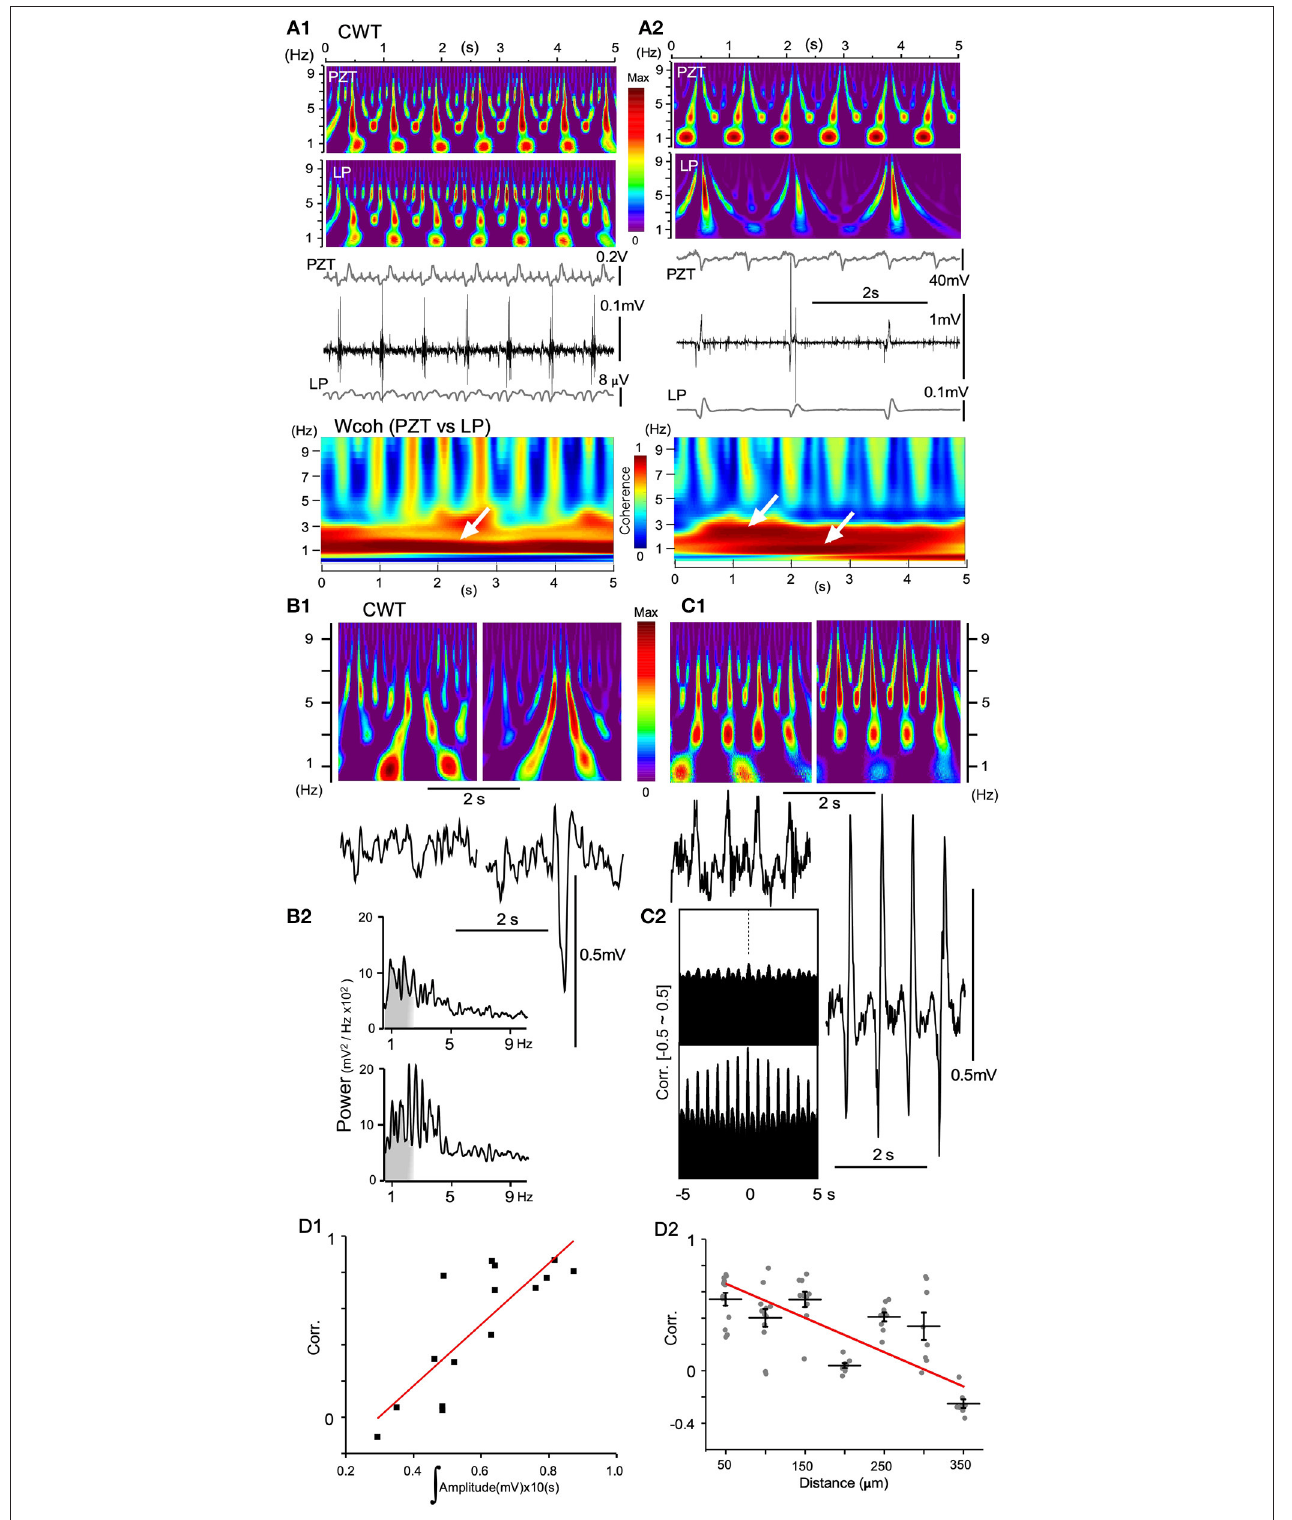
FIGURE 8 | Continuous wavelet transform (CWT) time-resolved power spectrum profiles predict signal amplitude and frequency. (A) Dynamics of vagal complex (VC) local field potentials (LFPs) obtained offline by digitally-low pass filtering (LP) in synchrony with piezoelectric pulse transducer (PZT) signals. (A1) LP signals (gray in